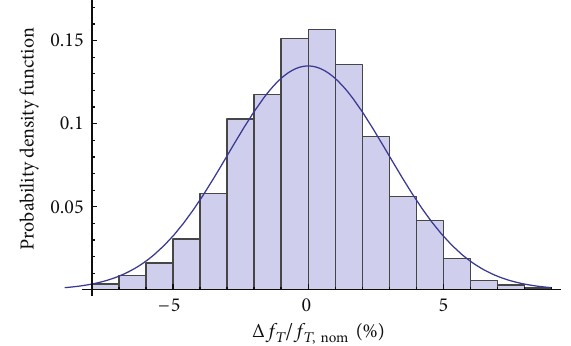
Figure 6: PMOS-based graphical comparison for the probability distribution of Δ𝑓 𝑇 : pdf Δ𝑓 tion from the circuit